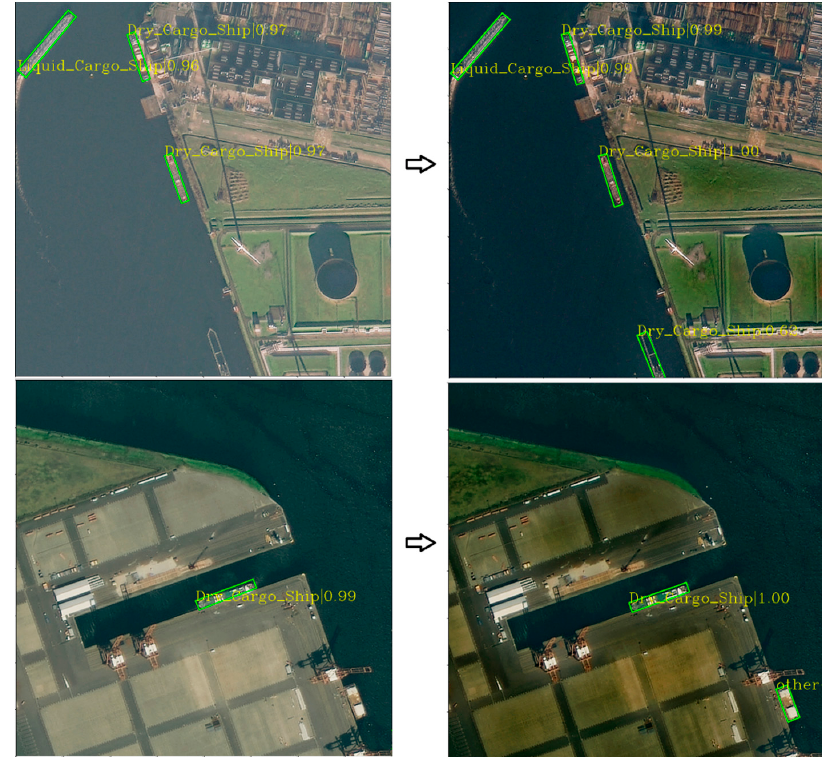
Figure 17. Detection effect of model before and after adding COT.